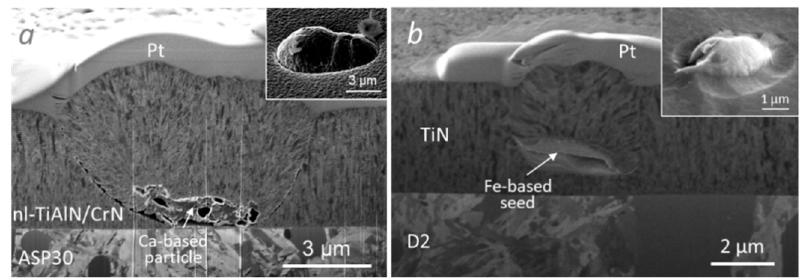
Figure 19. Top-view SEM (insets) and FIB images of nodular defects originating from Ca-based and Fe-based seeds. Nanolayer nl-TiAlN/CrN ( a ) and TiN ( b ) hard coatings were prepared by sputtering Fe-based seeds. Nanolayer nl-TiAlN / CrN ( a ) and TiN ( b ) hard coatings were prepared by sputtering and evaporation using a thermionic arc, respectively. and evaporation using a thermionic arc,